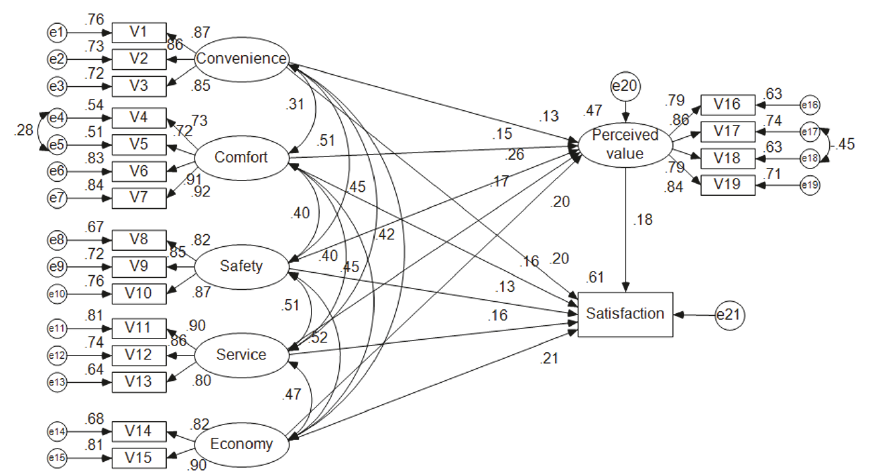
Figure 4: Results of the transit transfer satisfaction model.